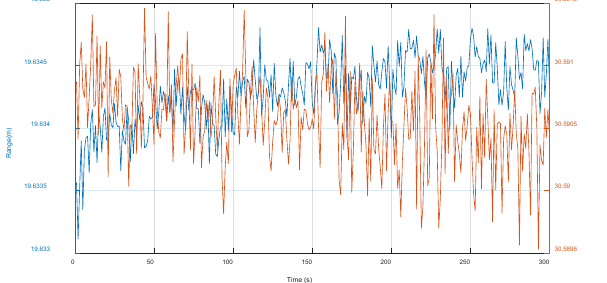
Fig. 5. Continuous monitoring results in the real scene. The blue line indicates the nearer target and the orange line indicates the farther